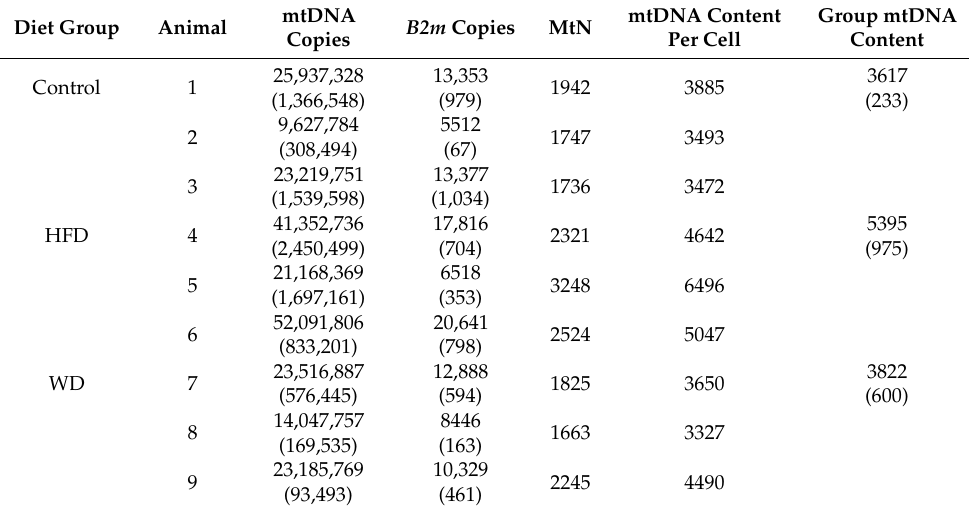
Table 1. Determination of absolute mitochondrial DNA (mtDNA) copy numbers per cell from mouse liver